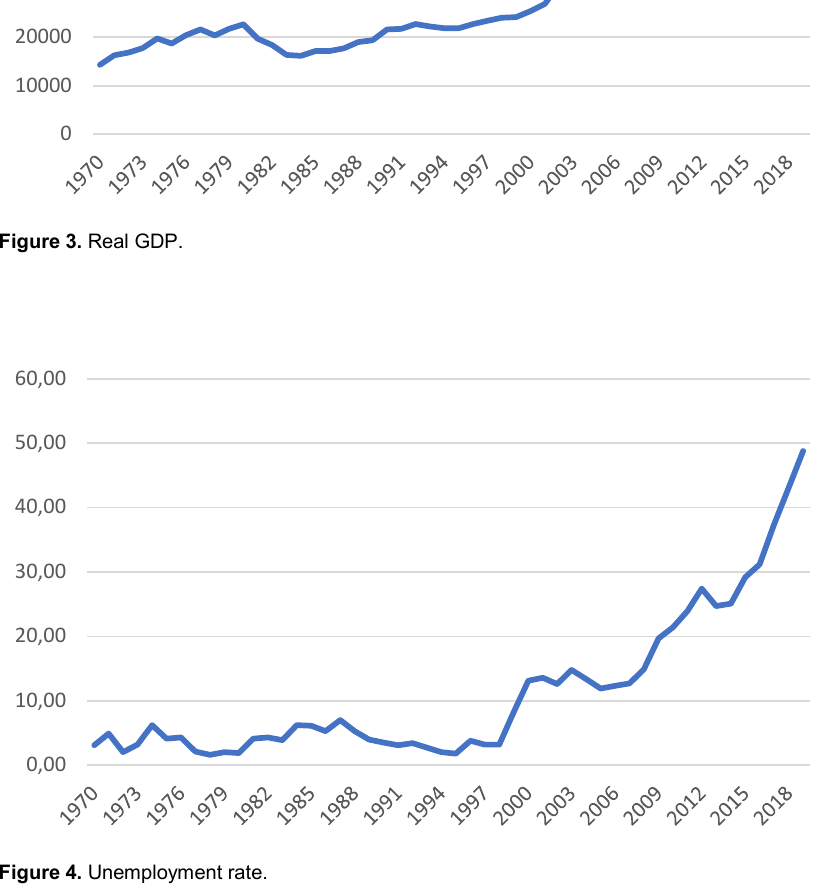
Figure 4. Unemployment rate.